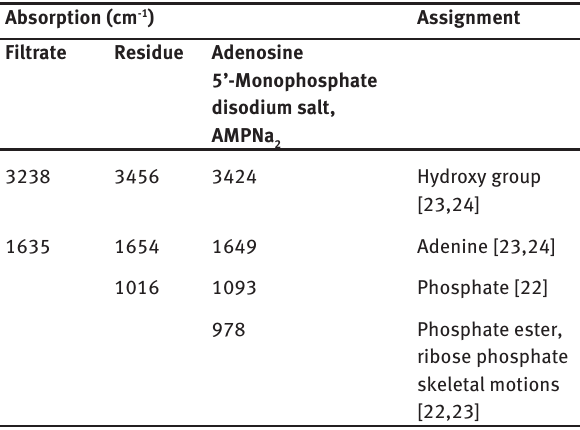
Table 2: Peak assignments of IR absorbance spectra for the substrate, residue and the filtrate obtained in alkaline hydrolysis of AMPNa at 60°C. 2